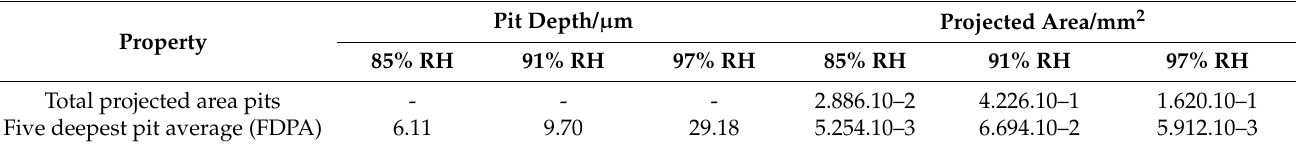
Table 5. Geometrical characteristics of mapped pits on the calibration cell surfaces exposed for 5 h with 86 μg NaCl/cm2 load at 21 °C.